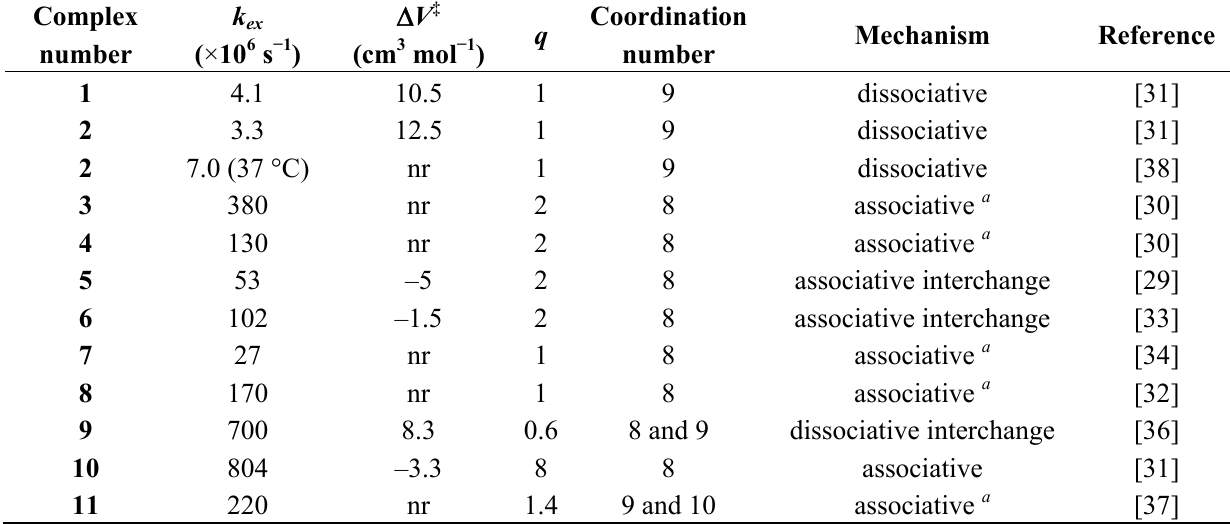
Table 1. Water-exchange parameters obtained from 17 O-NMR spectroscopy and coordination numbers of complexes 1 − 11